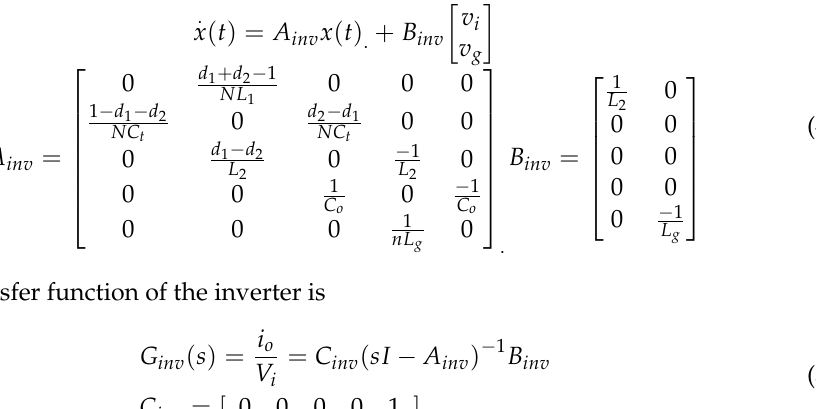
o is positive: ( a ) St rec 1 , ( b ) St rec 2 , and ( c ) St rec 3